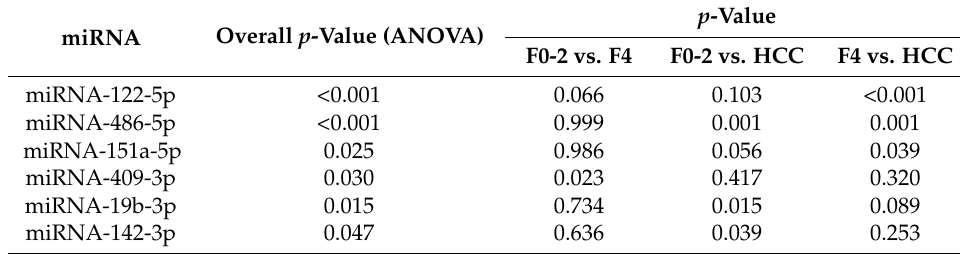
Table 1. Associations of circulating miRNA expression with the severity of disease in chronic Hepatitis C: Validation of selected miRNA expression levels using qRT-PCR.